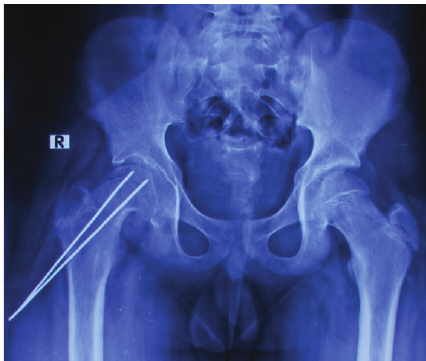
Figure 1: Postoperative radiograph showing K-wire fixation of the slipped capital femoral epiphysis at first surgery one year prior to presentation.